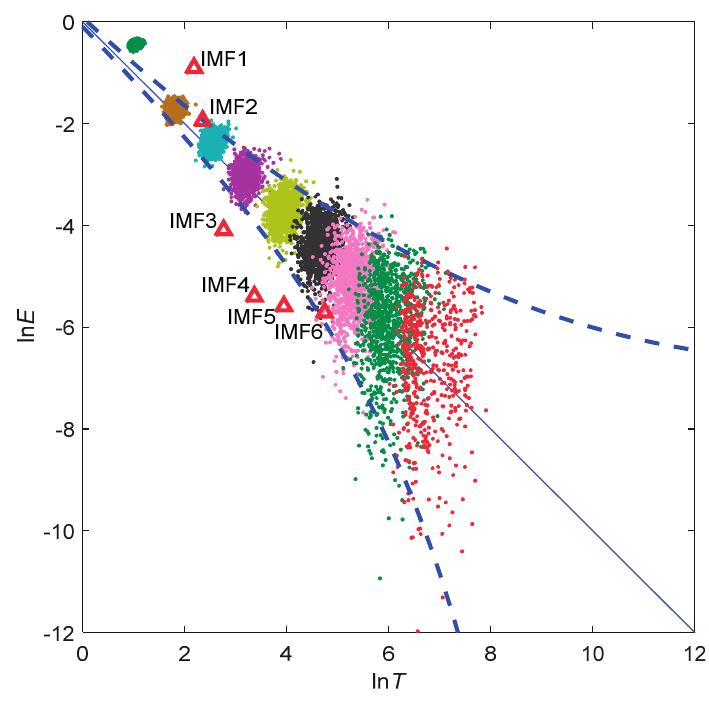
Figure 5. Illustration of the Monte Carlo